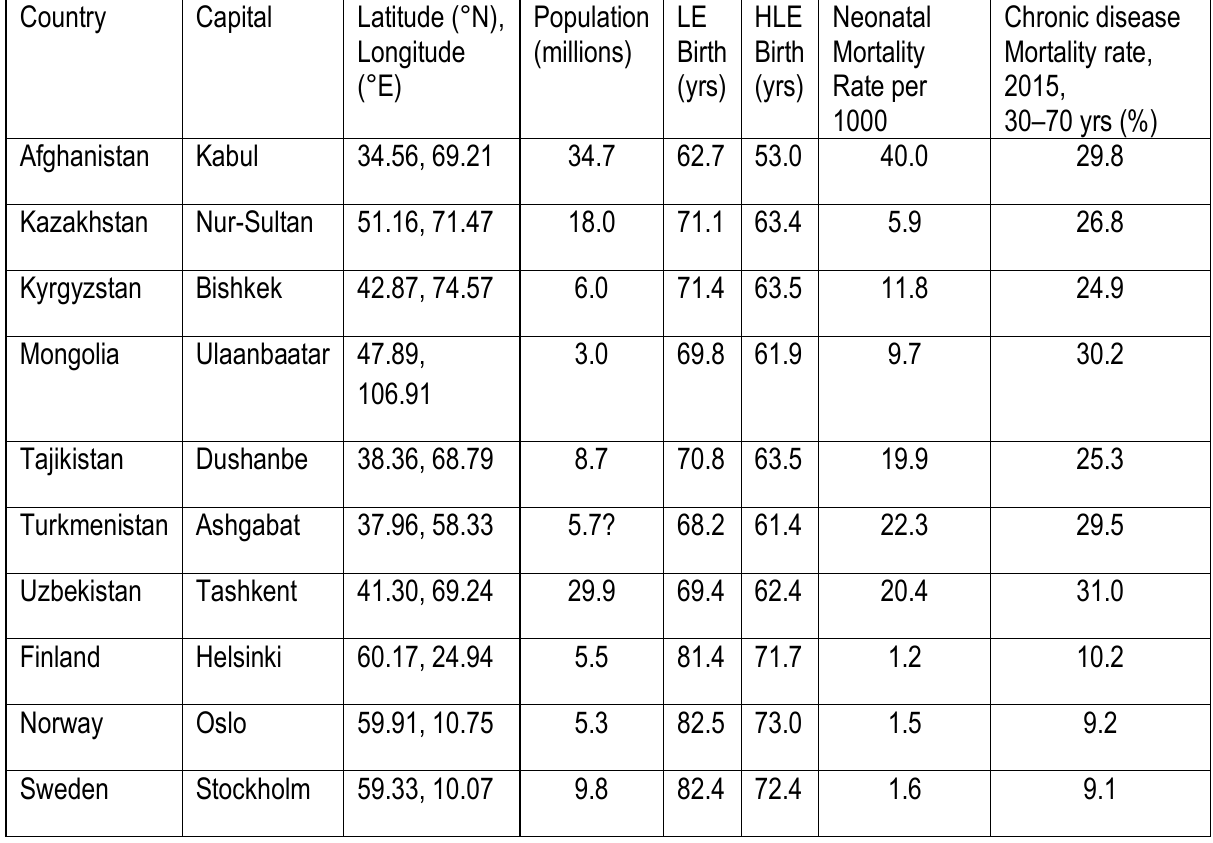
Table 1. Country data, 2017